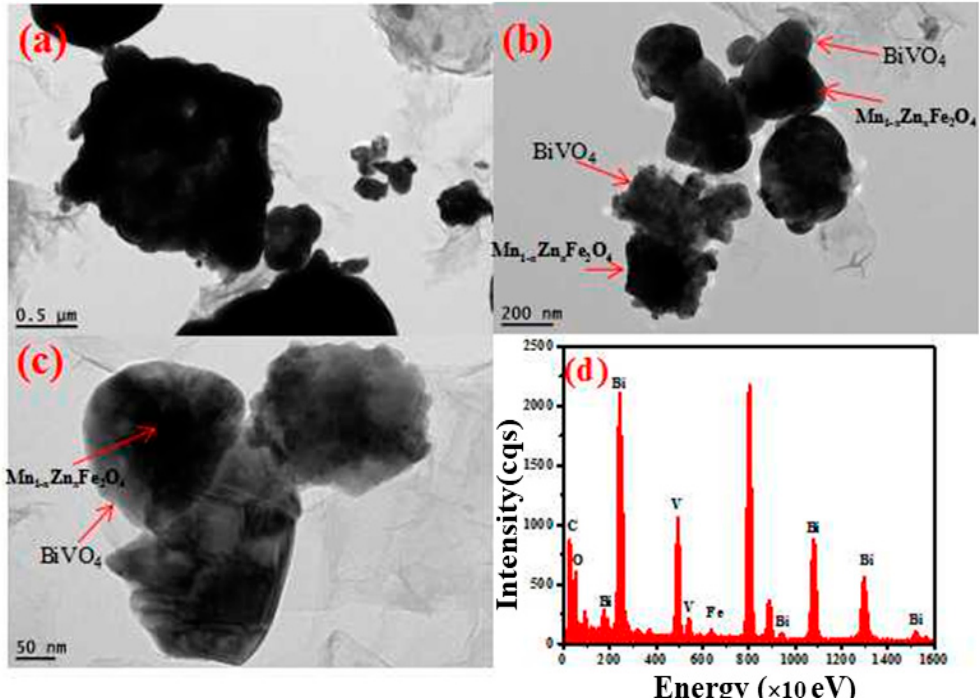
Figure 4. TEM images of Mn 1-x Zn x Fe 2 O 4 /BiVO 4 /RGO with different resolution ( a – c ) and ( d ) EDS of Mn 1-x Zn x Fe 2 O 4 /BiVO 4 /RGO.